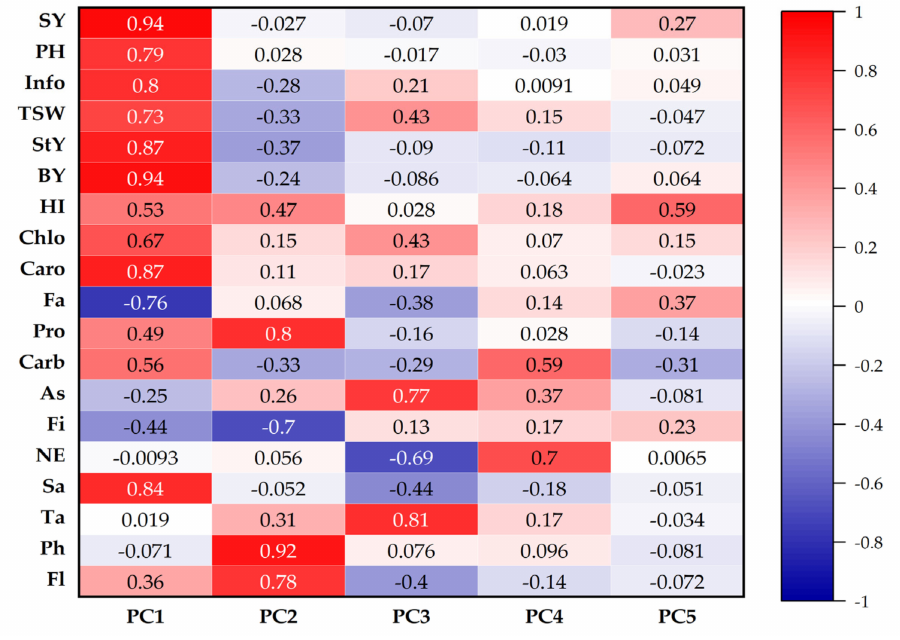
Figure 10. The plot of correlation between traits and components in